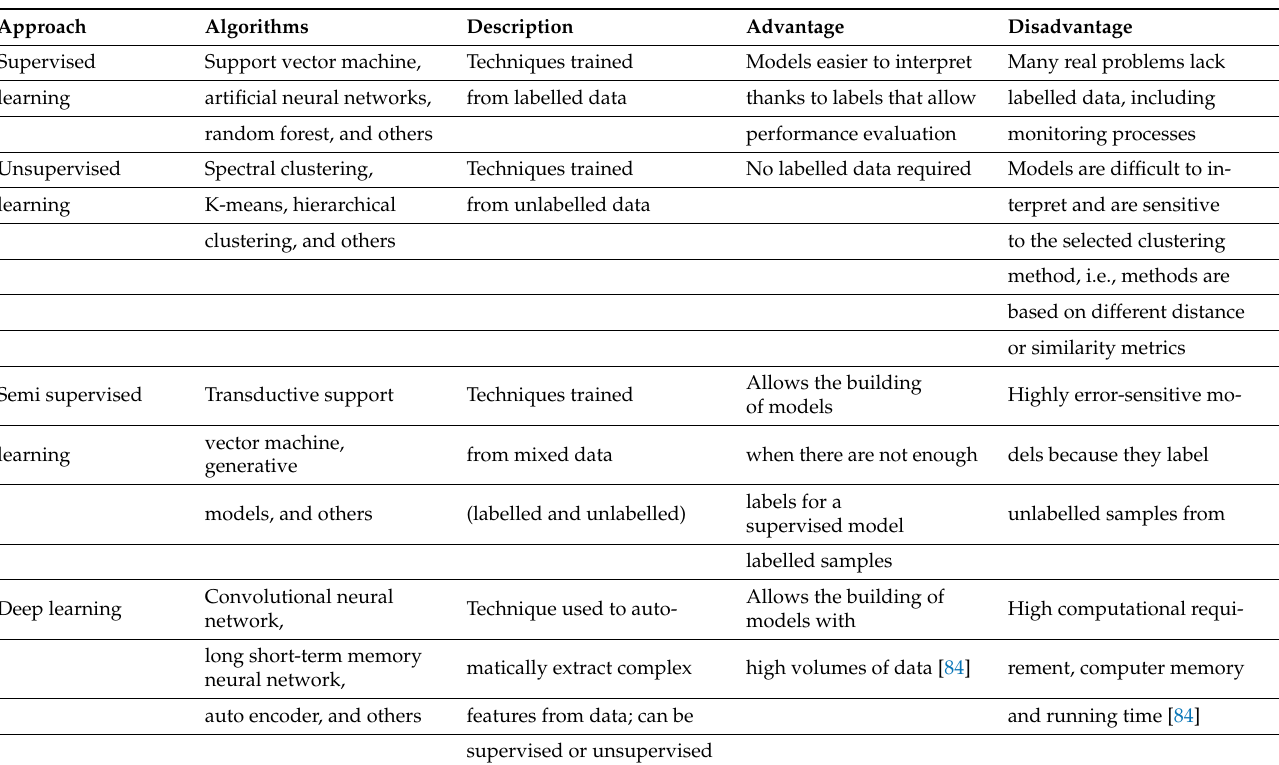
Table 2. Advantages and disadvantages of machine learning